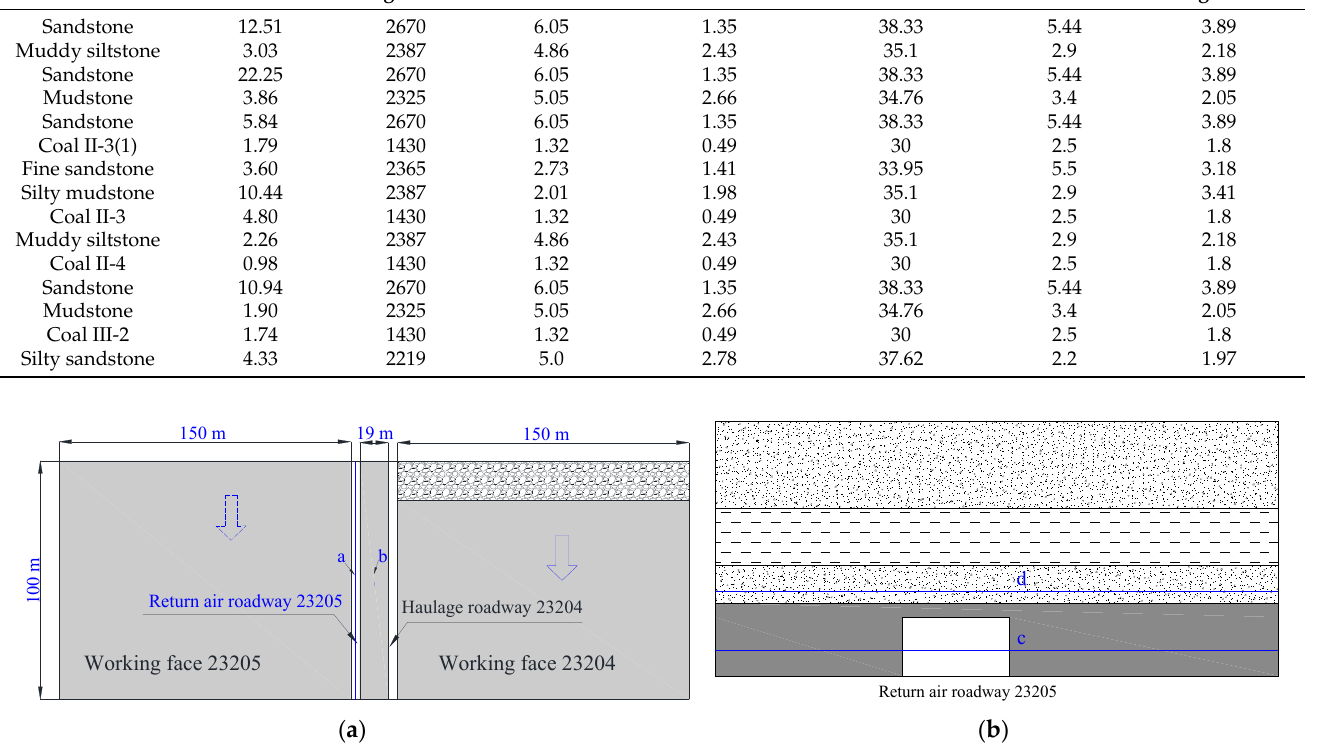
Figure 8. Mining sequence and monitoring lines layout of the working face: ( a ) strike monitoring lines’ layout and simulation scheme; ( b ) inclination monitoring lines’ layout.